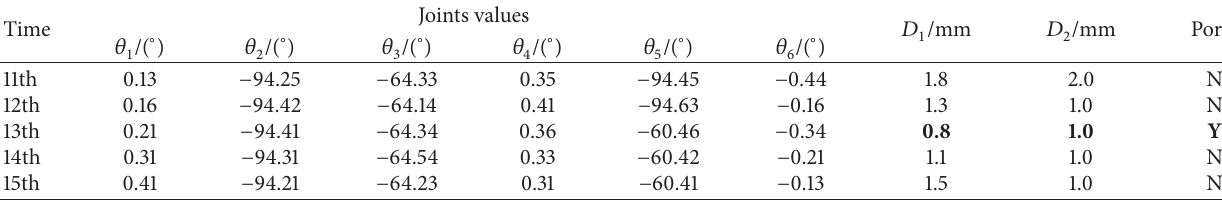
Table 1: The results of the safe pipe.